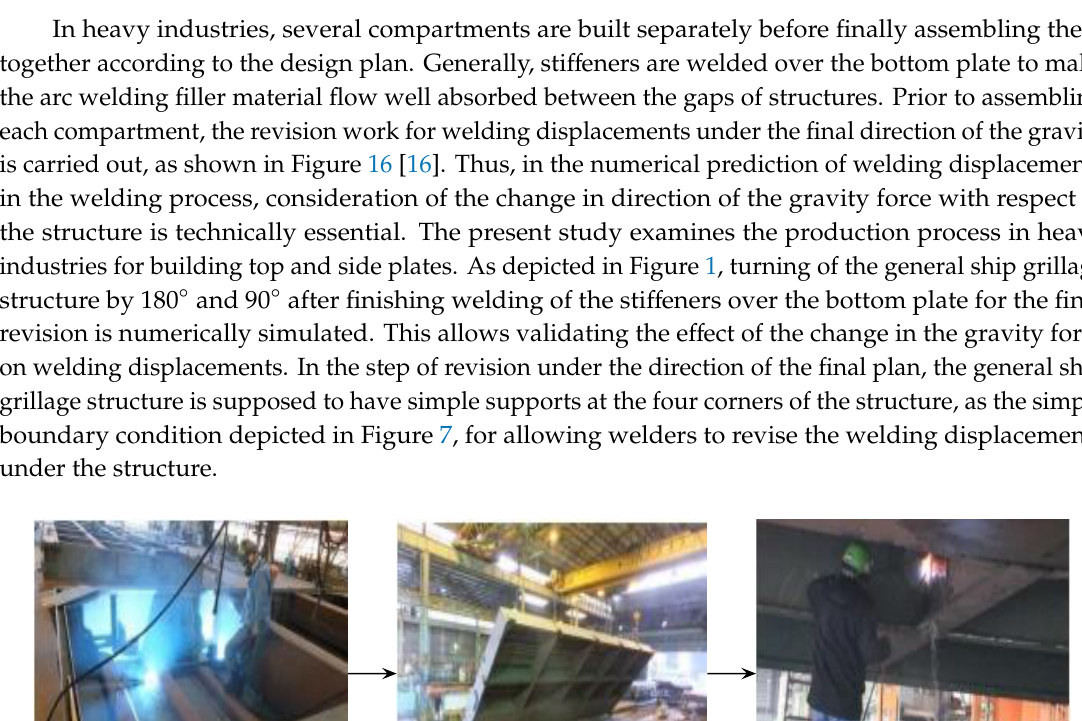
Figure 15. Z-axis displacement distribution along line L of Sequence B-10 under two different boundary conditions.